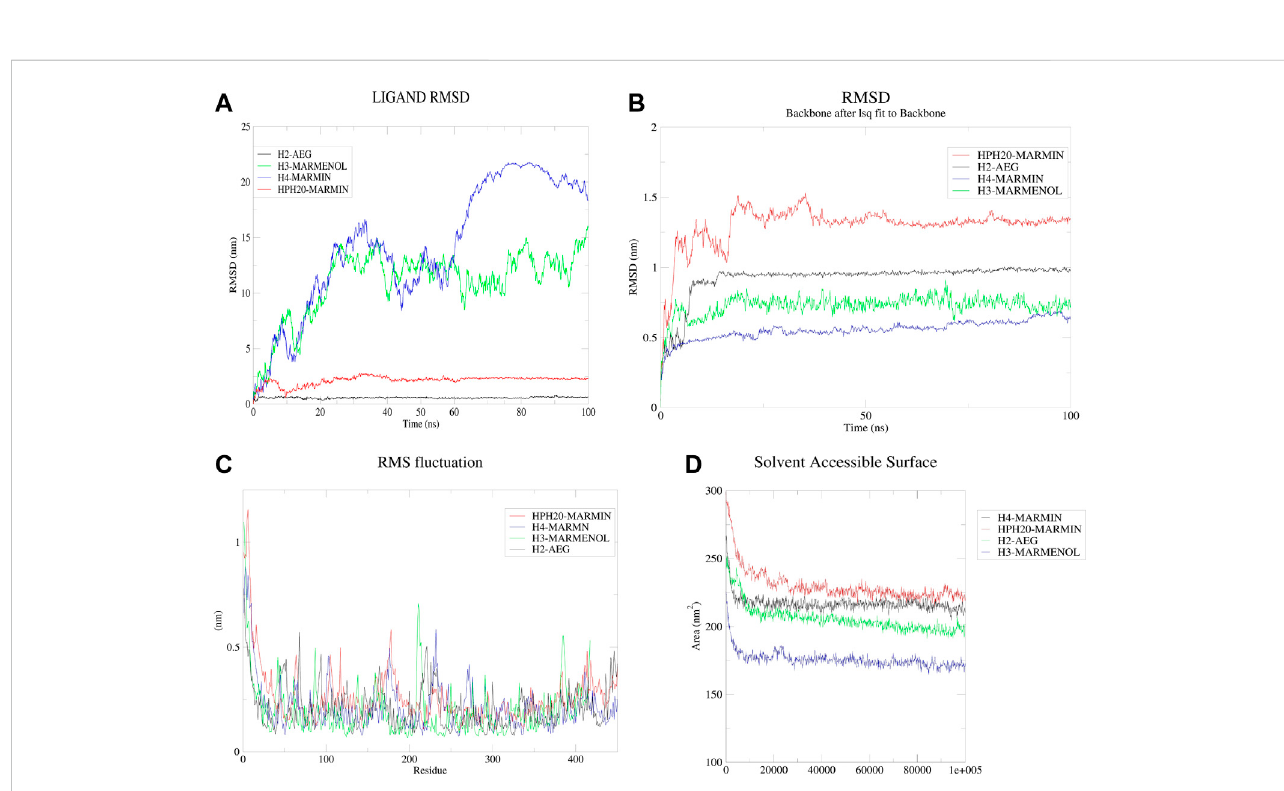
FIGURE 8 (A – D) (clockwise): Molecular dynamics results such as Ligand RMSD, protein backbone RMSD, RMSF and SAS for the protein-ligand complexes.